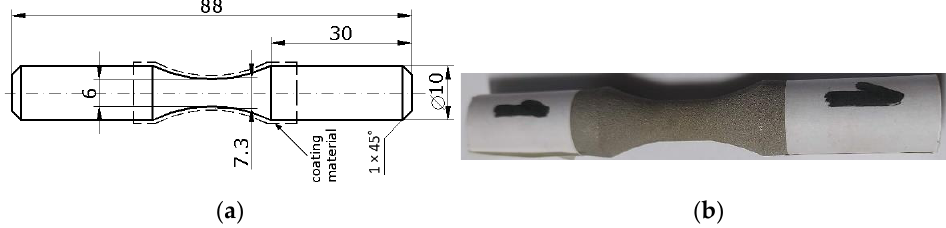
Figure 1. Details of tensile test sample: ( a ) Sample shape and dimensions (mm), ( b ) coated sample.